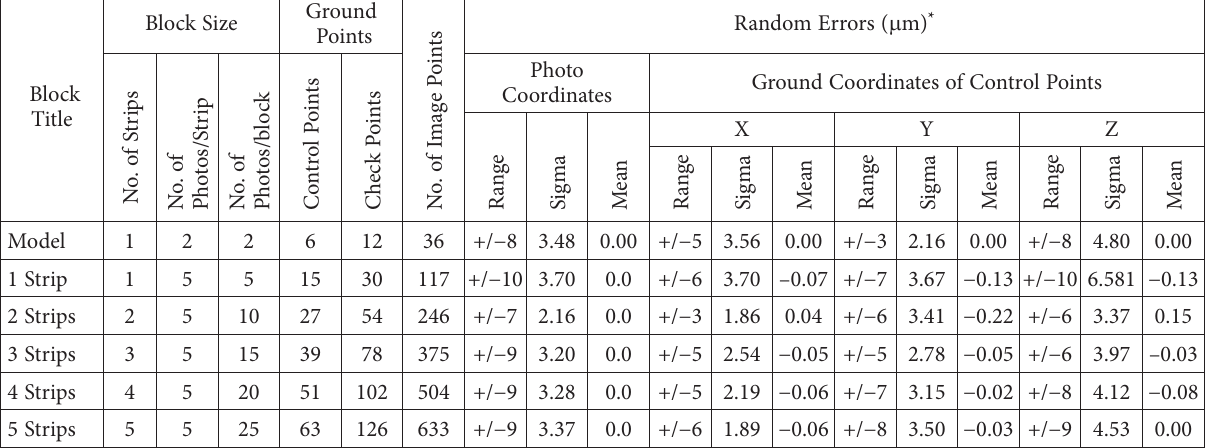
Table 2. Configurations for mathematical photogrammetric blocks of